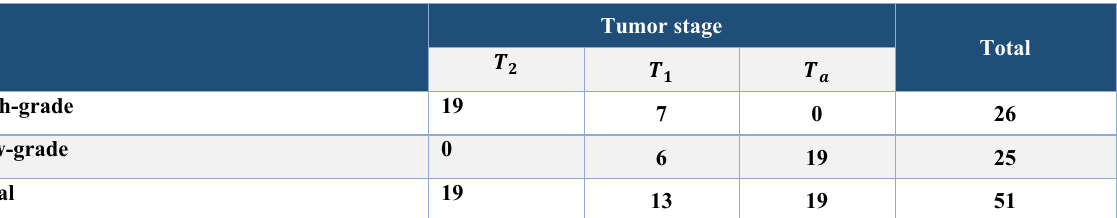
Table 1. Crossover frequency table according to tumor grade and